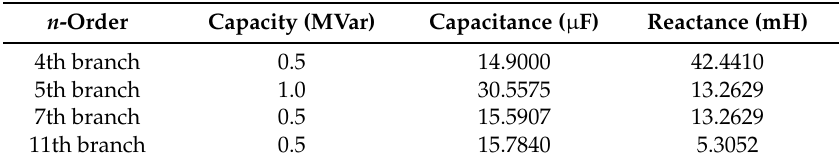
Table 2. Design parameters of the FT